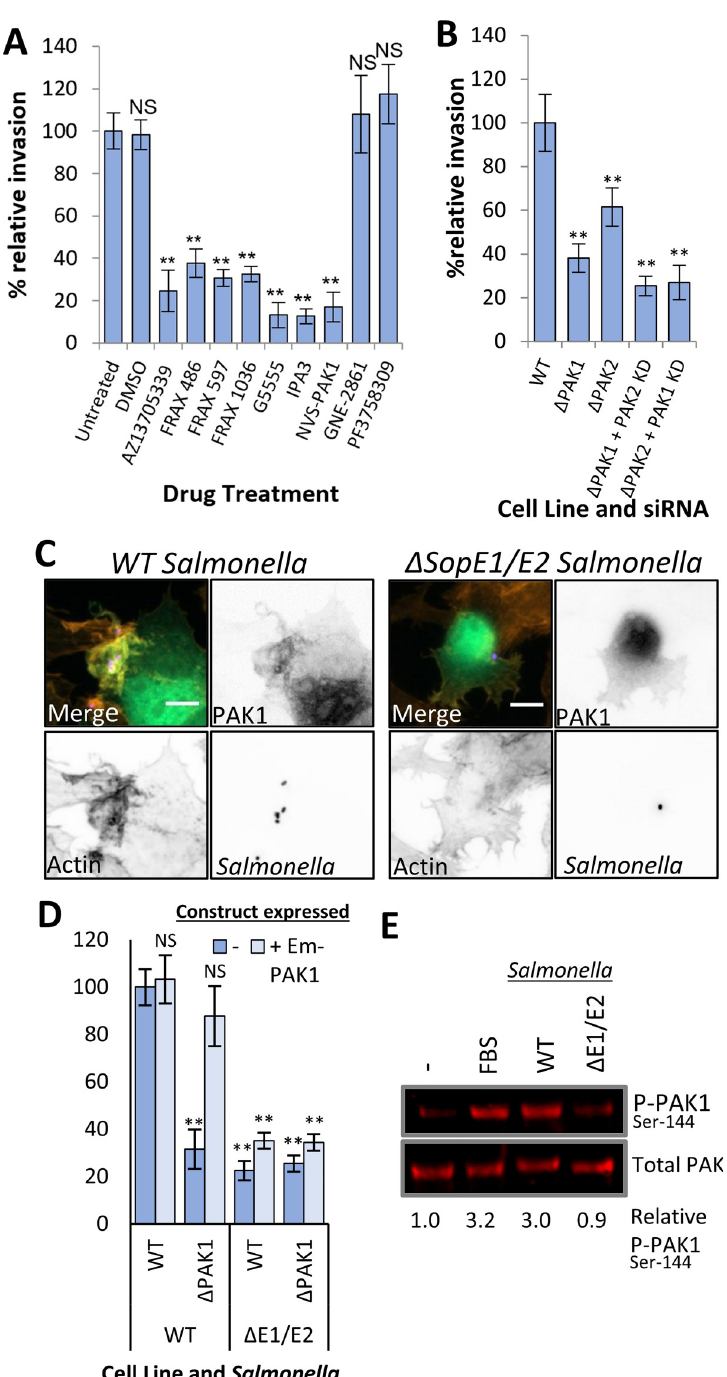
Fig 1. Class I PAKs are crucial for Salmonella uptake. (A) WT Hap1 cells were untreated, pretreated with DMSO (controls) or one of the PAK inhibitors AZ13705339, FRAX 486, FRAX 597, FRAX 1036, G5555, IPA3, NVS-PAK1, GNE-2861 or PF3758309 prior to infection with WT Salmonella for 20 mins. Invasion values are relative to those in untreated Hap1 cells. (B) Invasion of Salmonella (20 mins) into WT, Δ PAK1, Δ PAK2 Hap1 cells as well as Δ PAK1 cells pretreated with PAK2 siRNA and Δ PAK2 cells pretreated with PAK1 siRNA. All values relative to invasion into WT Hap1 control cells. (C) Fluorescence microscopy of Δ PAK1 Hap1 cells expressing Emerald-PAK1 (green), infected with either WT or Δ SopE1/E2 Salmonella (both 10 mins) that had been prestained with Alexa-Fluor 350 (blue). Cells also stained with Texas-Red Phalloidin to visualise actin (red). Scale bar is 10 μ m. (D) Invasion of WT and Δ SopE1/E2